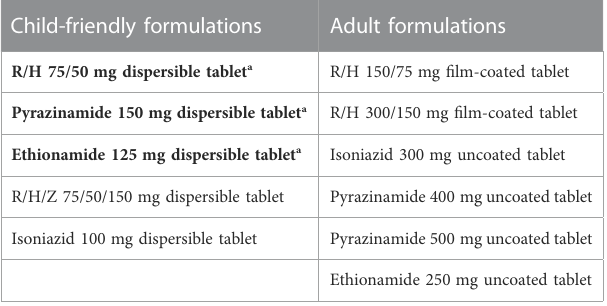
TABLE 1 Globally available formulations at the time of dosing table